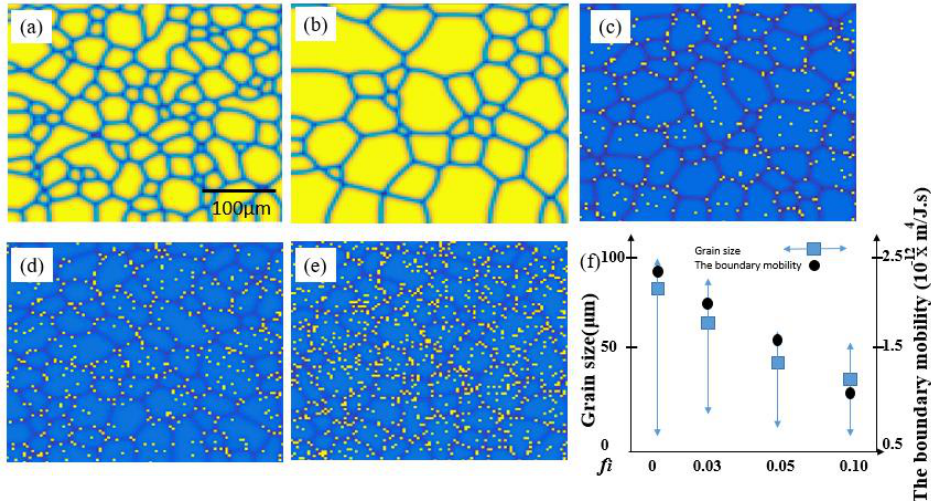
Figure 7. ( a ) Initial simulated grain structure, and simulated grain structure after holding for 1200 s at 1300 °C ( b ) for f i = 0, ( c ) f i = 0.03, ( d ) f i = 0.05, and ( e ) f i = 1. ( f ) The relationship between grain size and grain size variation with inclusion volume fraction.